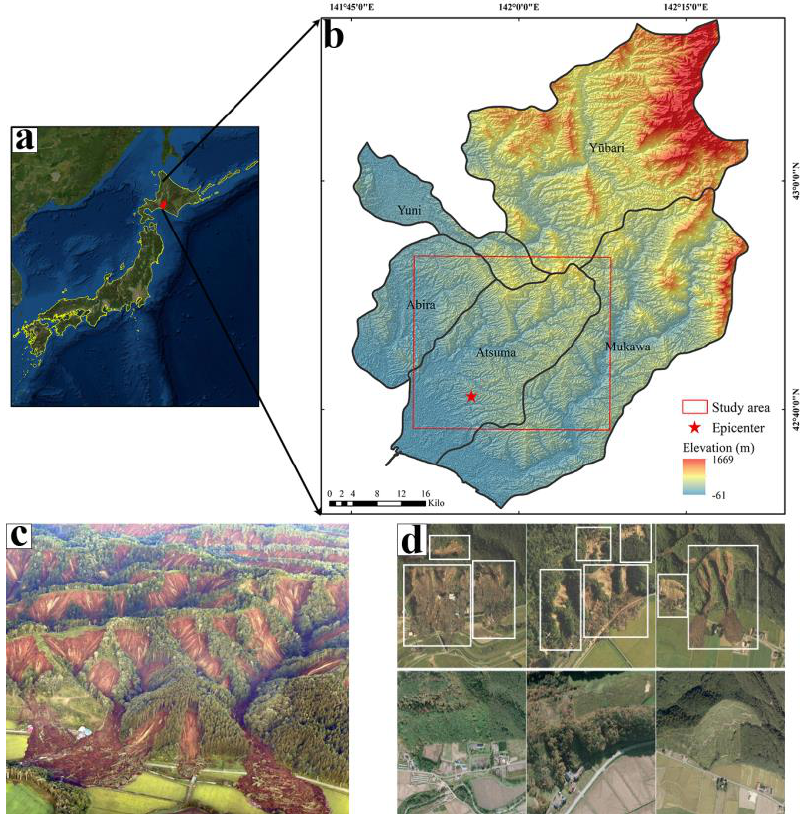
Figure 1. Location of the study area ( a ) and its topography ( b ). Aerial photos of landslides ( c , d ). The solid white boxes in ( d ) show the location of